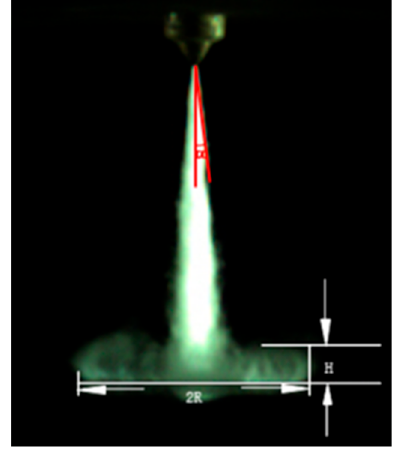
Figure 5. Experimental extraction of R, H, and α .